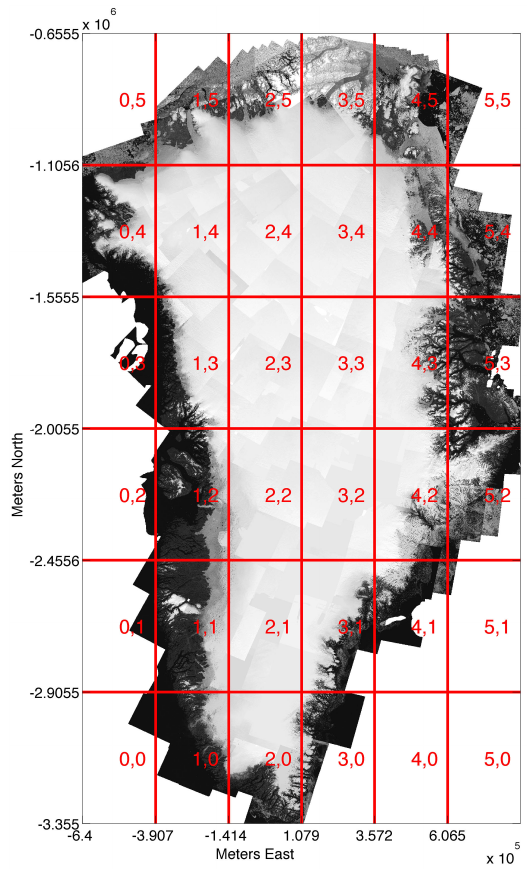
Figure 1. GIMP Landsat-7 ETM + band-8 and RADARSAT-1 mo- saic of Greenland with tile boundaries and tile numbers overlain. The map projection is polar stereographic (EPSG